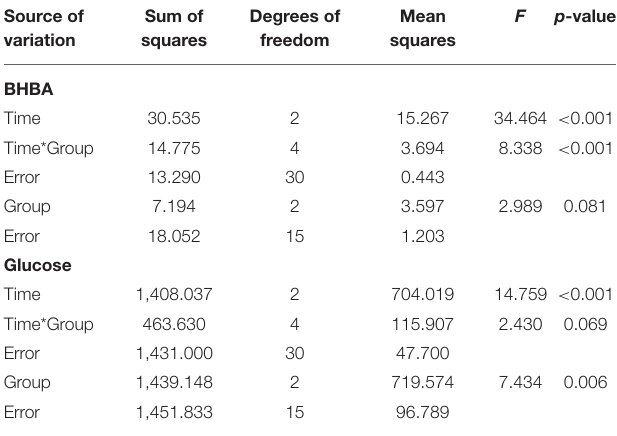
glucose ( p = 0.006), but not significant in BHBA ( p = 0.081). TABLE 3 | Interaction effect of time and group on BHBA and glucose concentration by repeated measures ANOVA.